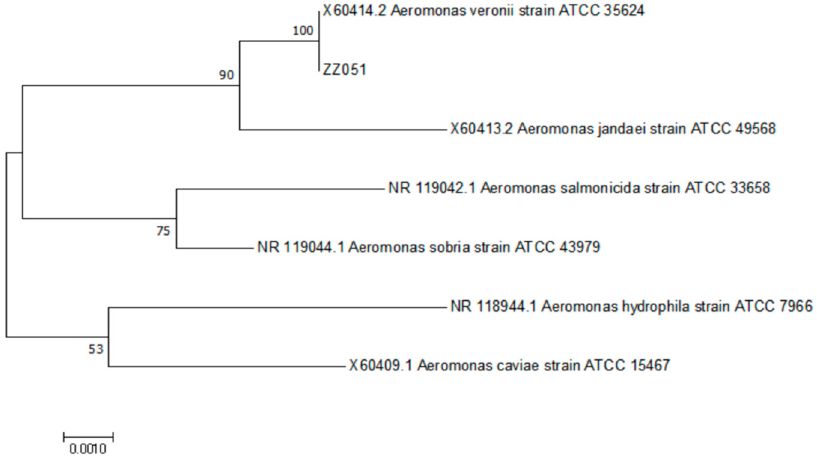
Figure 5. The phylogenetic relationships based on 16S rRNA sequence comparisons between strain ZZ051 and other fish-pathogenic Aeromonas .